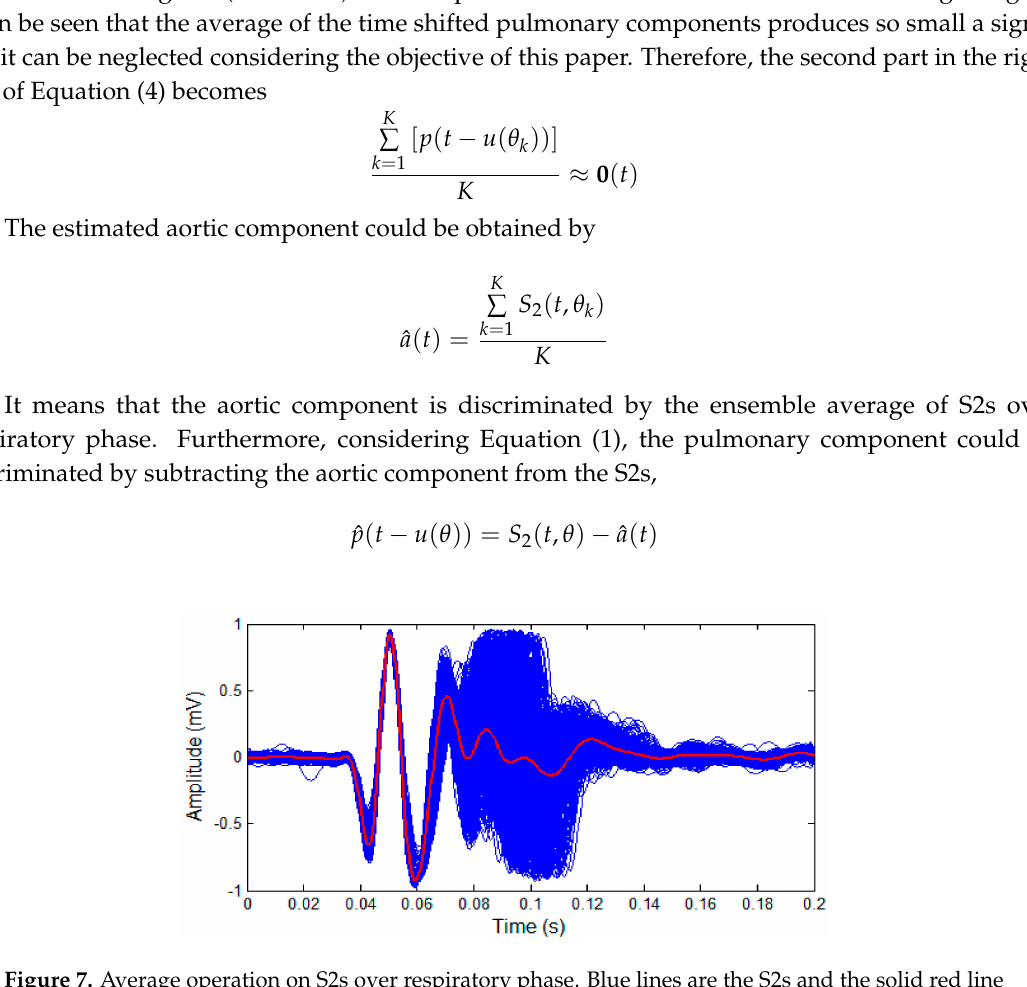
Figure 7. Average operation on S2s over respiratory phase. Blue lines are the S2s and the solid red line is the average. It can be seen that the aortic component remains. Meanwhile, the average of pulmonary components produces a very small